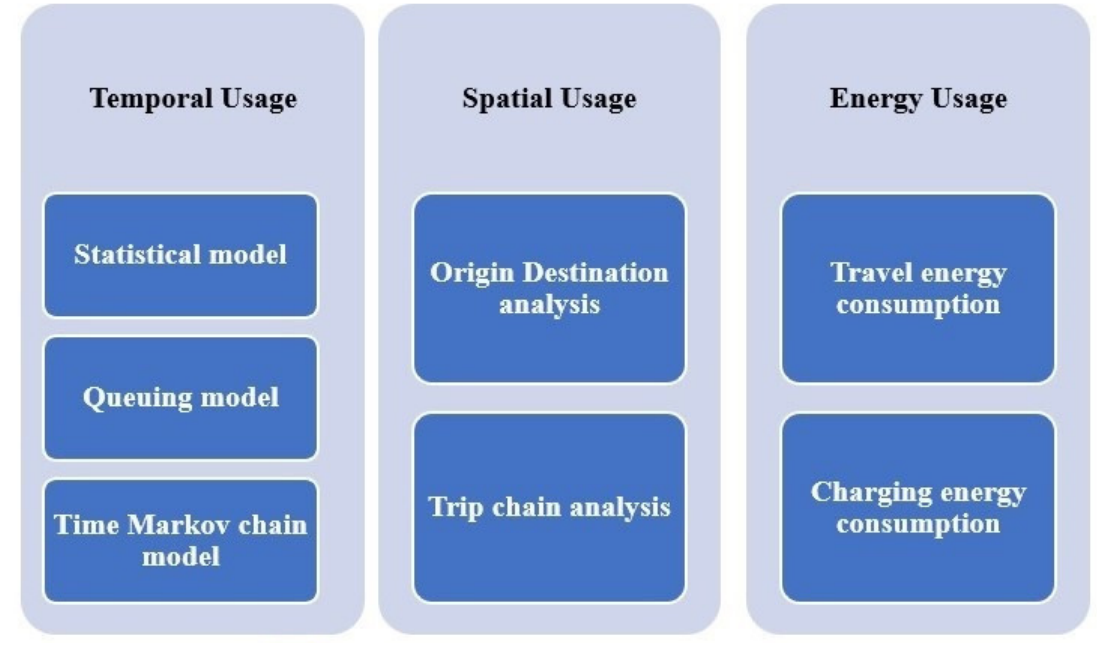
Figure 10. EV Usage models.